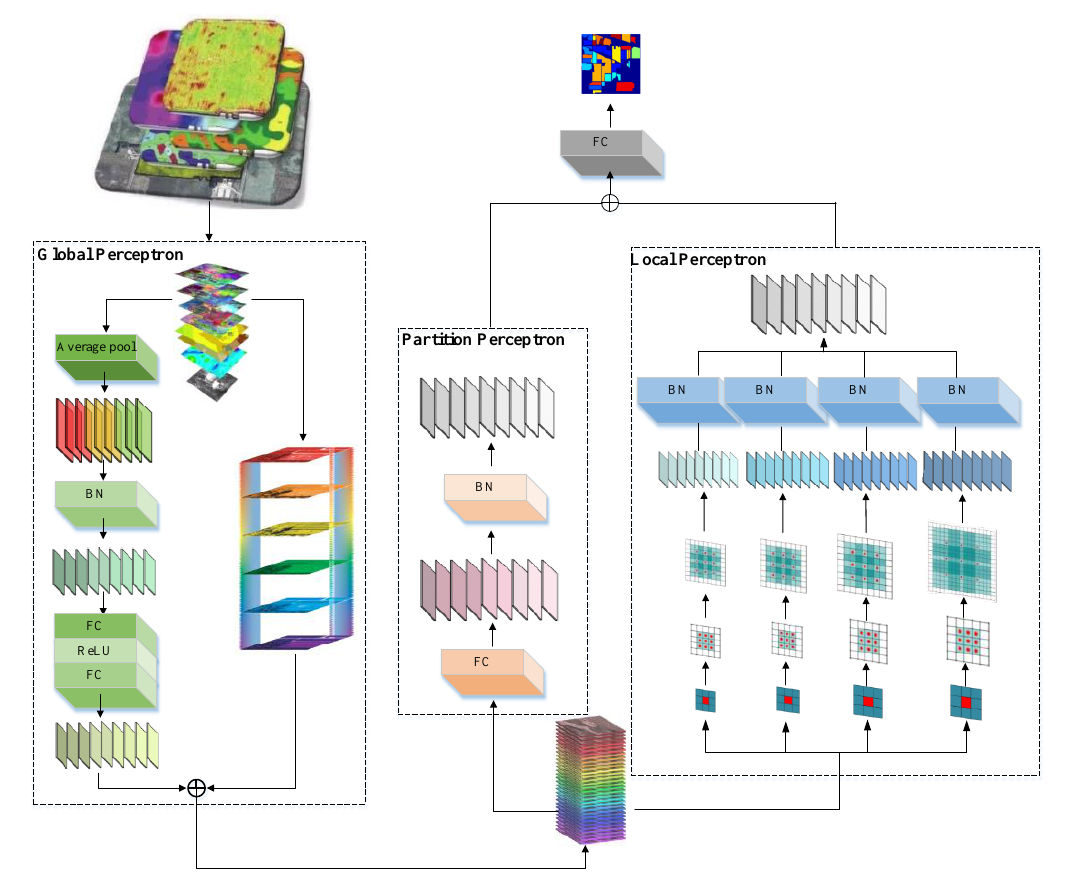
Figure 2. The structure of DMLP for HSI classification.